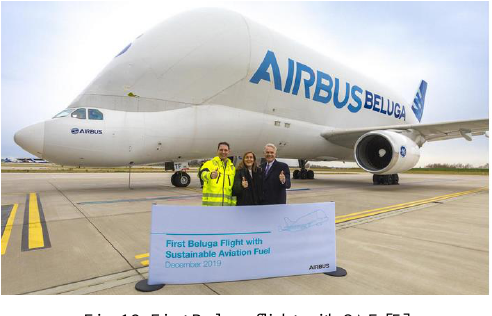
Fig. 12. First Beluga flight with SAF [5]